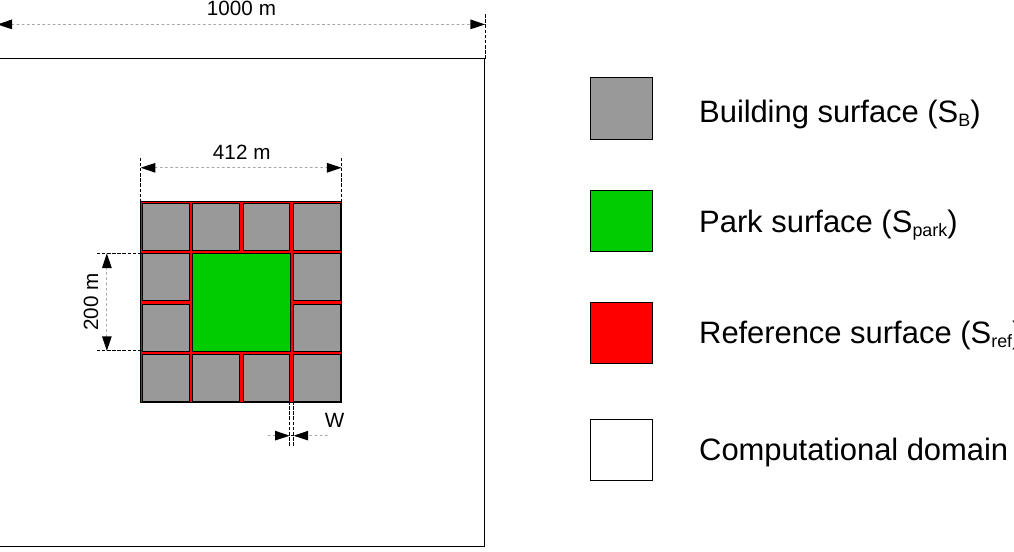
Figure 1. Study area and parameter definition—note that the reference surface consists of the entire square surface